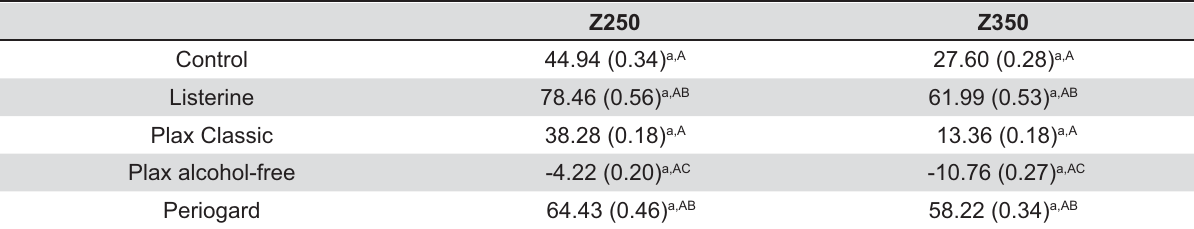
Color stability, surface roughness and microhardness of composites submitted to mouthrinsing Table 2- Means (standard deviations) for R (cid:21)(cid:31)(cid:9)(cid:4)(cid:21)K(cid:5)(cid:14)(cid:28)(cid:17)%(cid:21)(cid:31)!H&(cid:5)(cid:15)(cid:21)|}~(cid:127)|(cid:26)(cid:21)(cid:128)(cid:24)(cid:20)>(cid:17)(cid:18)(cid:18)(cid:24)(cid:20)(cid:19)(cid:129)%(cid:21)"(cid:17)%"(cid:130)(cid:21)(cid:25)(cid:131)(cid:8)(cid:12)(cid:8)(cid:10)(cid:4) a